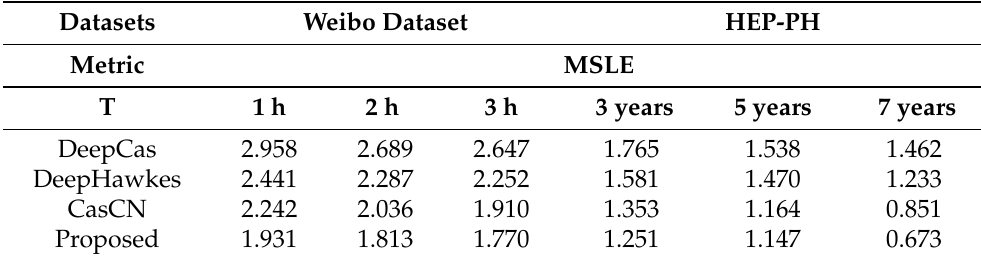
Table 2. Overall performance